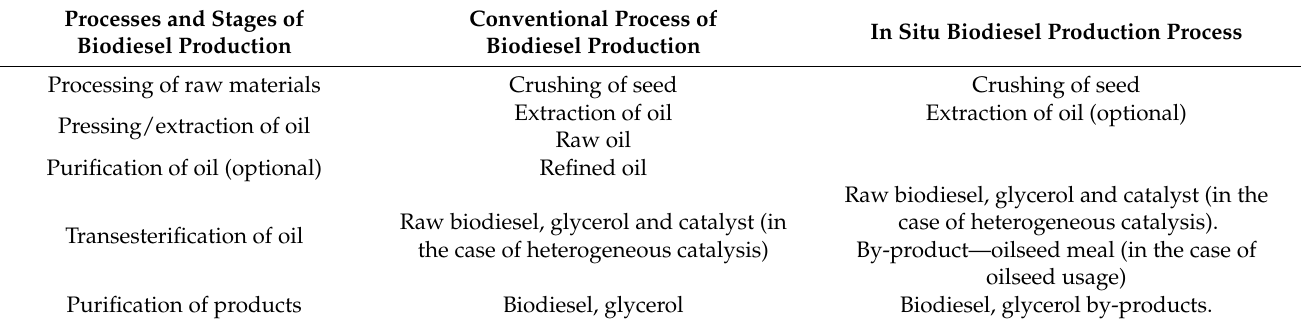
Table 1. Comparison of the stages of traditional and in situ biodiesel production